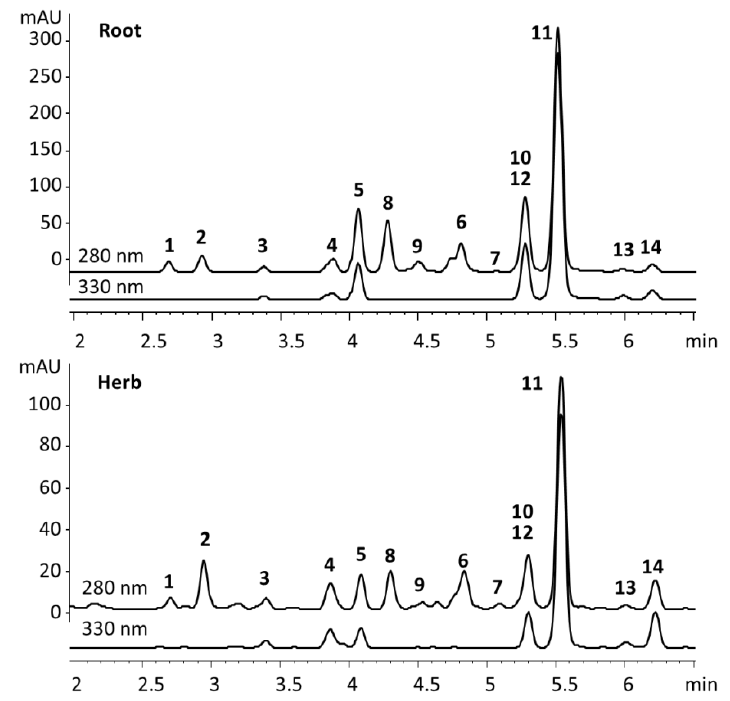
Figure 2. UV chromatograms of representative root and herb extracts. Table 1. Content of lignans in root (R) and herb (H) extracts of A. sylvestris , in mg/g d.w. The results are presented as the average ± standard deviation of 5–8 biological replicates.